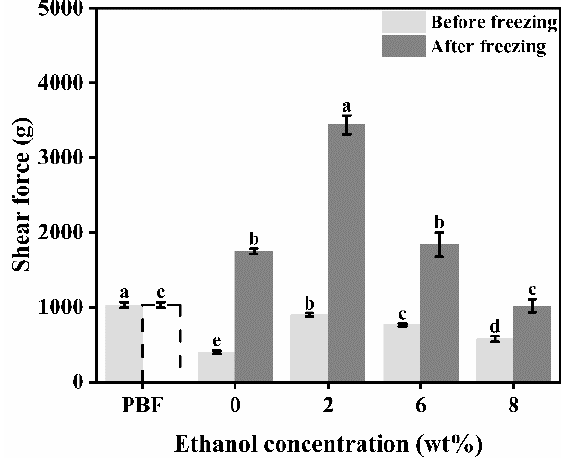
Figure 2. Shear force of pork back fat (PBF) and konjac emulgel-based fat analogue (KGFA) with different ethanol content before and after freeze-thaw treatment. Dotted line indicates that PBF was not frozen. Different letters indicate significant differences in columns of the same color ( p < 0.05).